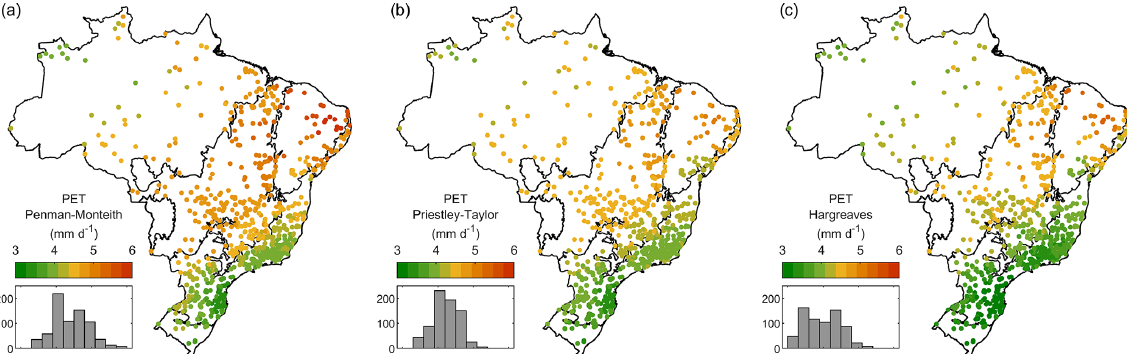
Figure 5. Spatial distribution of the PET calculated from three different methods of the CABra catchments. (a) Penman–Monteith method, (b) Priestley and Taylor method, and (c) Hargreaves